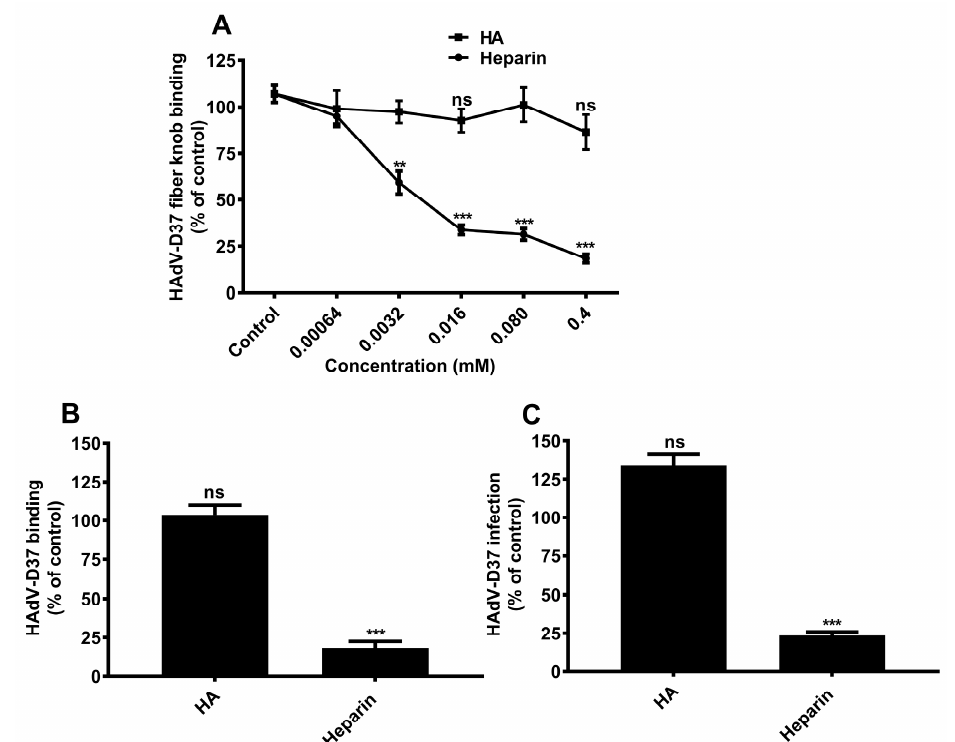
Figure 3. Sulfate groups of glycosaminoglycans (GAGs) are critical for interaction between HAdV-D37 and GAGs. ( A ) Binding of His-tagged HAdV-D37 fiber knobs, pre-incubated with increasing concentrations of heparin and HA, to HCE cells. Binding of fiber knobs to cells is presented as percentage binding of untreated fiber knobs. ( B ) Binding of 35 S-labeled HAdV-D37, pre-incubated with heparin (0.4 mM) and HA (0.4 mM), to HCE cells. Binding of virus to cells is presented as percentage binding of untreated viruses. ( C ) HAdV-D37, pre-incubated with heparin (0.4 mM) and HA (0.4 mM), infection of HCE cells. Infection of cells is presented as percentage infection of untreated virus. Error bars represent mean ± SEM. ns = not significant. ** P < 0.01 and *** P < 0.001 relative to control.